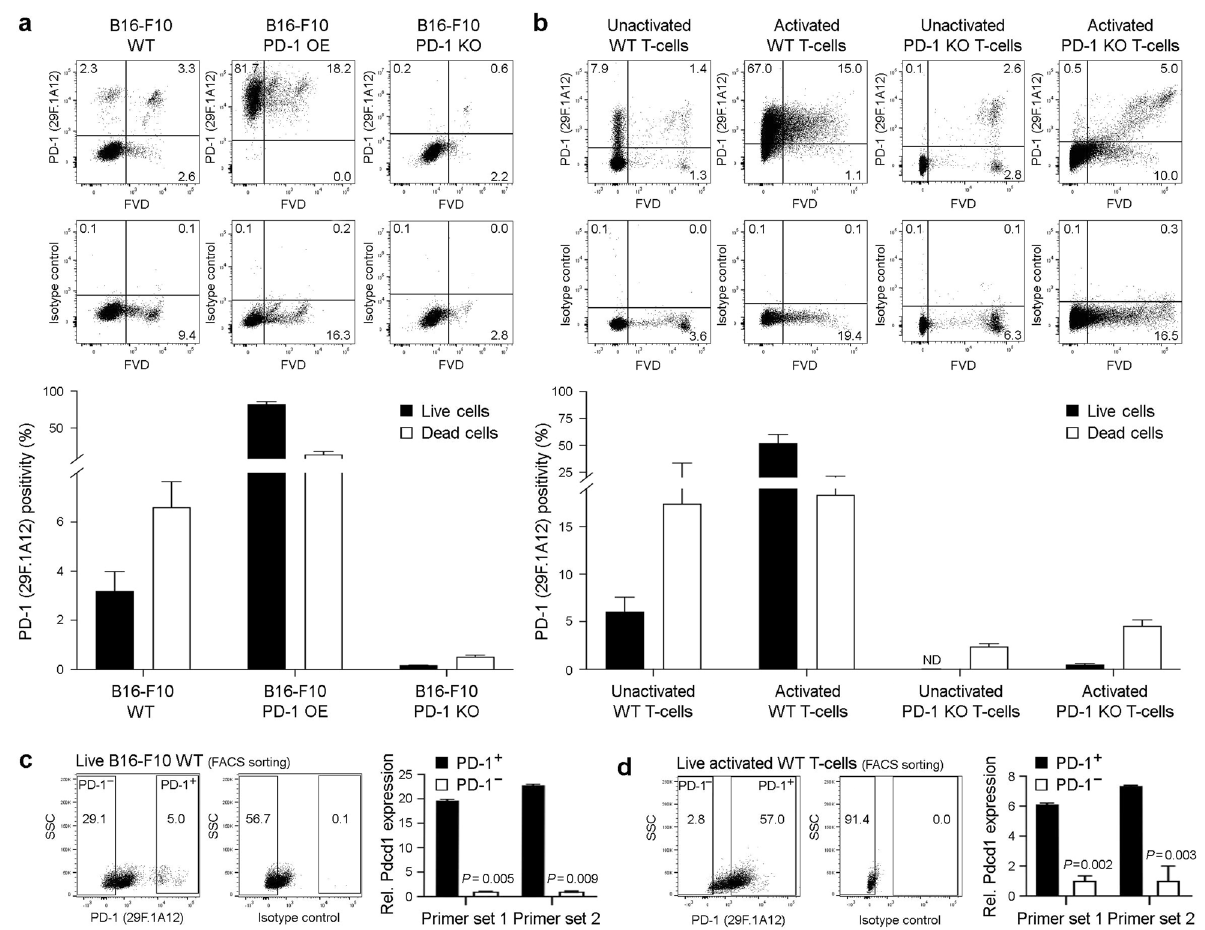
Figure 2. The anti-PD-1 29F.1A12 monoclonal antibody recognizes PD-1 surface protein on live B16-F10 melanoma cells. ( a,b ) Representative FACS plots of surface PD-1 protein expression (clone 29F.1A12) or isotype control staining and % positivity (mean ± s.e.m.) on live versus dead (fixable viability dye, FVD-negative or -positive, respectively) ( a ) B16-F10 wild-type (WT), PD-1-overexpressing (OE), or PD-1 knockout (KO) melanoma cells, or on ( b ) unactivated versus activated WT or PD-1 KO T-cells (C57BL/6), respectively. ( c,d ) Relative Pdcd1 expression (mean ± s.d., two distinct primer sets), as determined by real-time qPCR (right), in FACS-sorted (29F.1A12, left) live (FVD − ) ( c ) PD-1 + versus PD-1 − B16-F10 WT melanoma cells or ( d ) respective activated WT (C57BL/6) T-cell subsets. All results are representative of at least n = 3 independent experiments. ** p < 0.01; ND, not